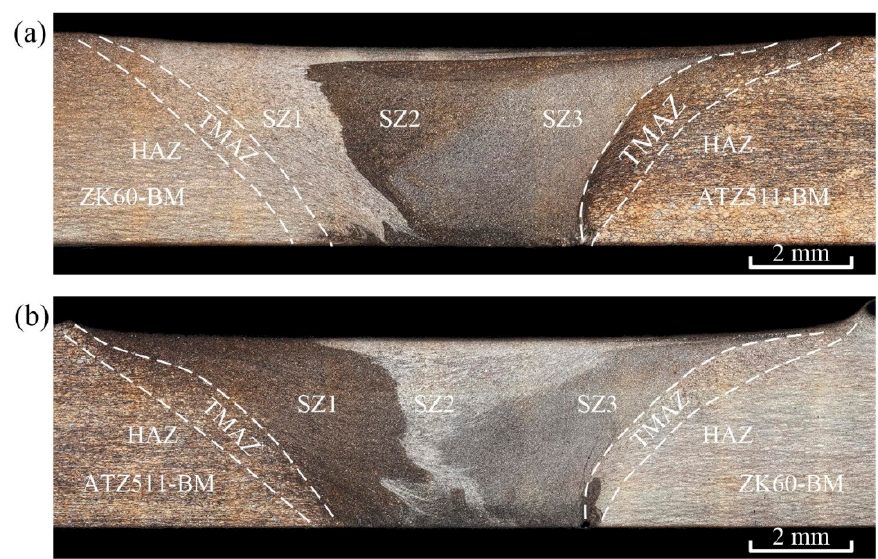
Figure 3. OM images at horizontal plane with depth of 1.2 mm around keyhole of the two welded joints: ( a ) ZK60/ATZ511 joint, ( b ) ATZ511/ZK60 joint.